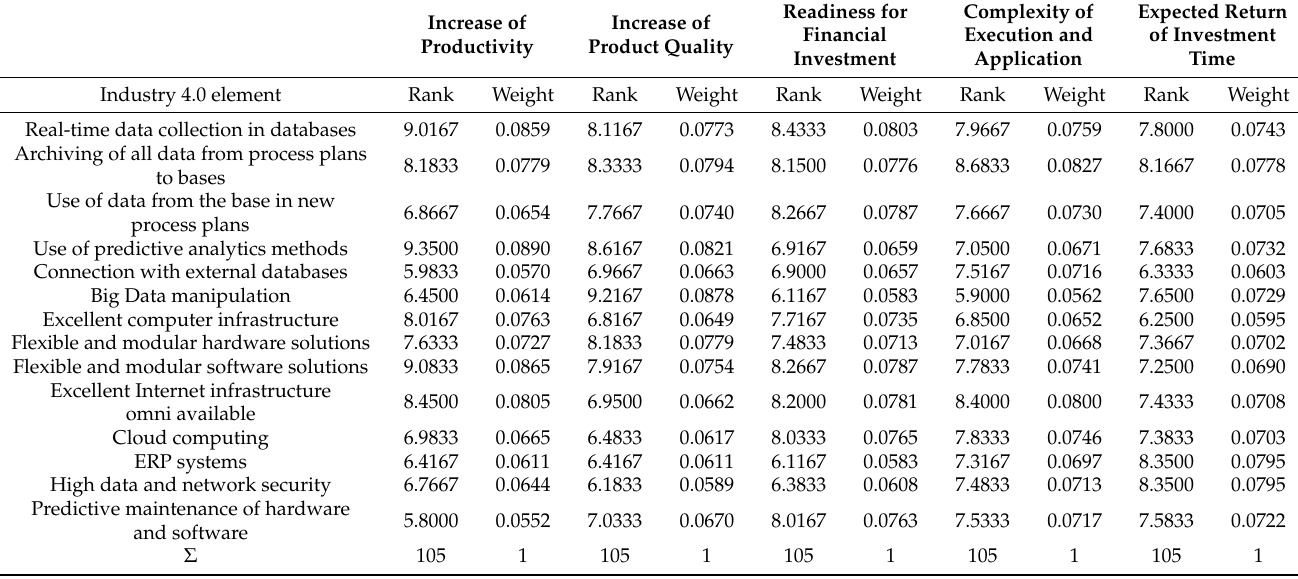
Table 5. Ranks of the elements from the “infrastructure”